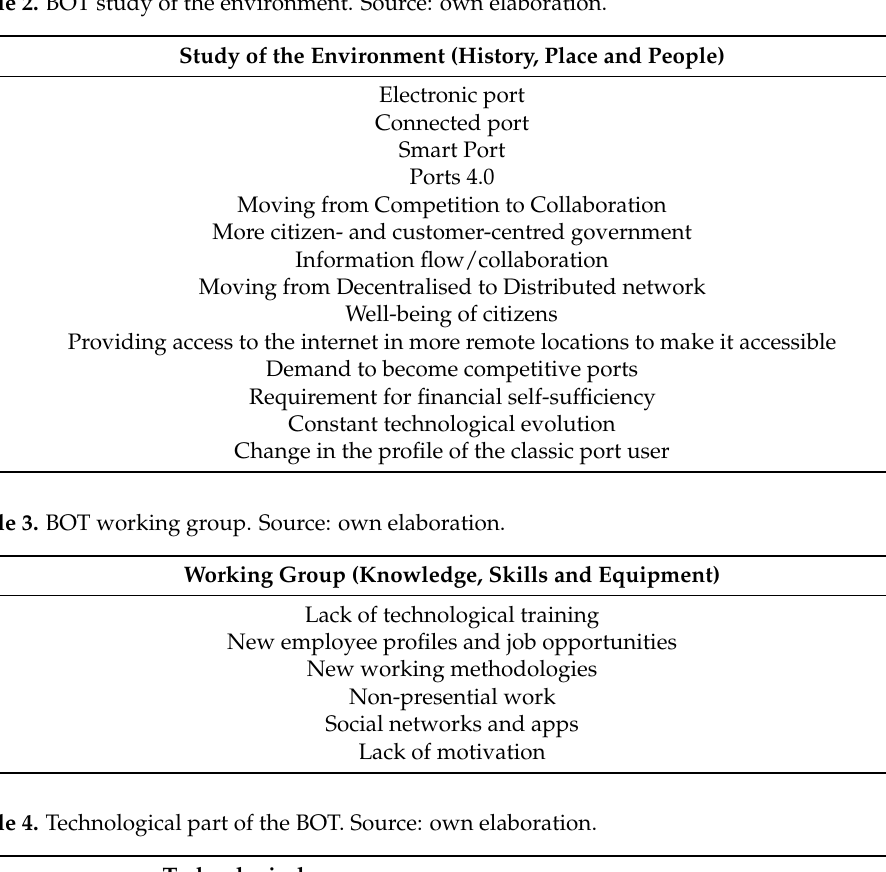
Table 2. BOT study of the environment. Source: own elaboration.